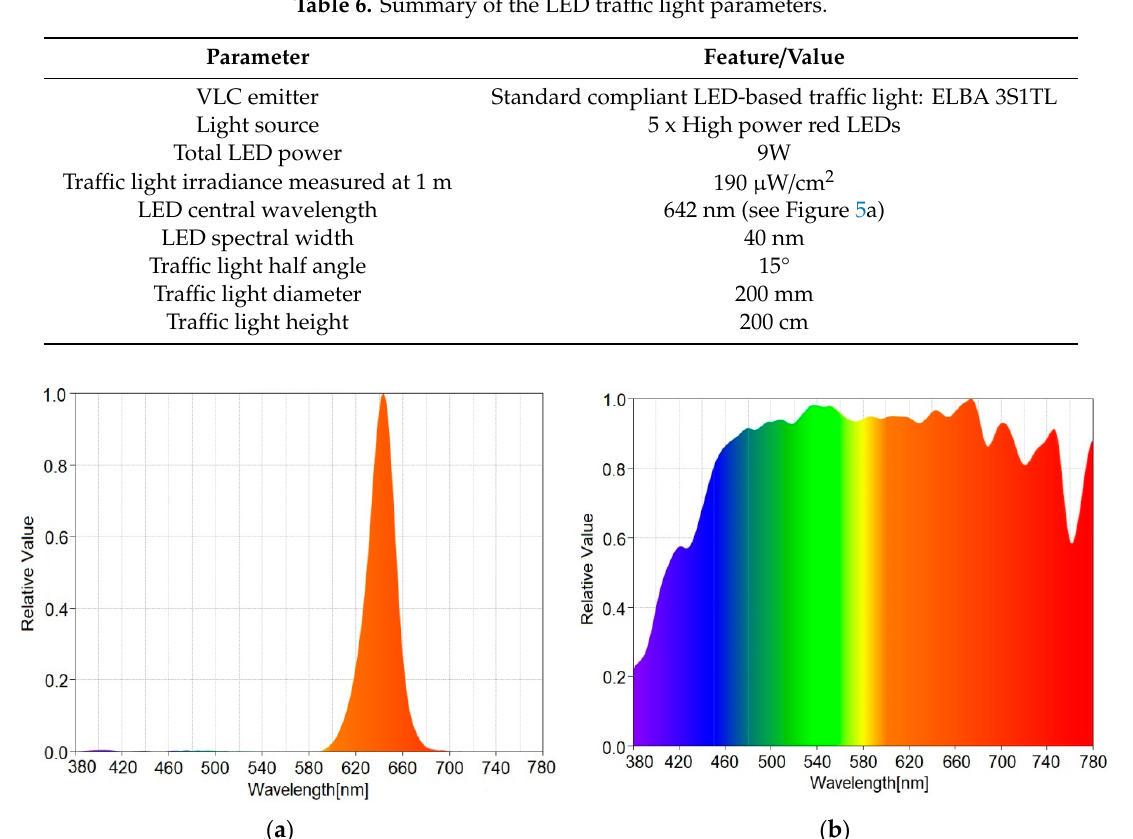
Table 6. Summary of the LED tra ffi c light parameters.